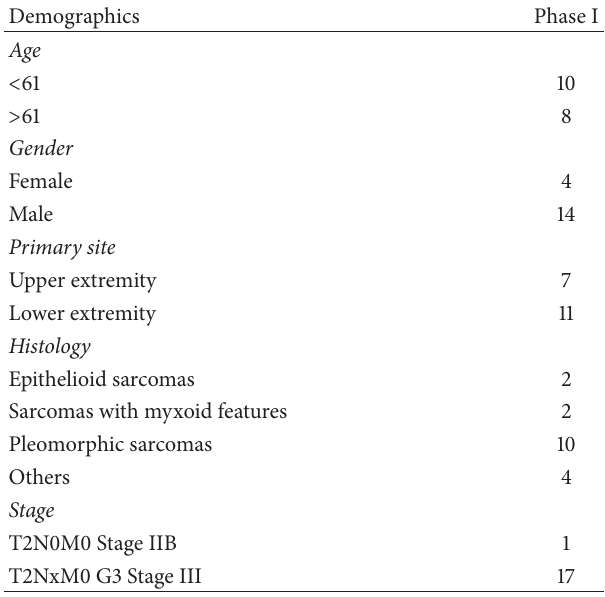
Table 1: Demographics and clinical characteristics of patients enrolled on combined treatment of neoadjuvant radiation and dendritic cell